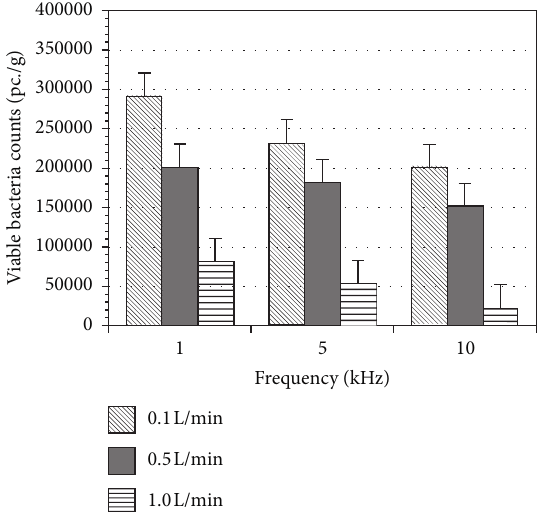
Figure 6: Relationship between DC pulse frequency and variety bacteria count and oxygen gas ratio in Staph Express Count Plate on 3M ™ Petrifilm ™ CC (in